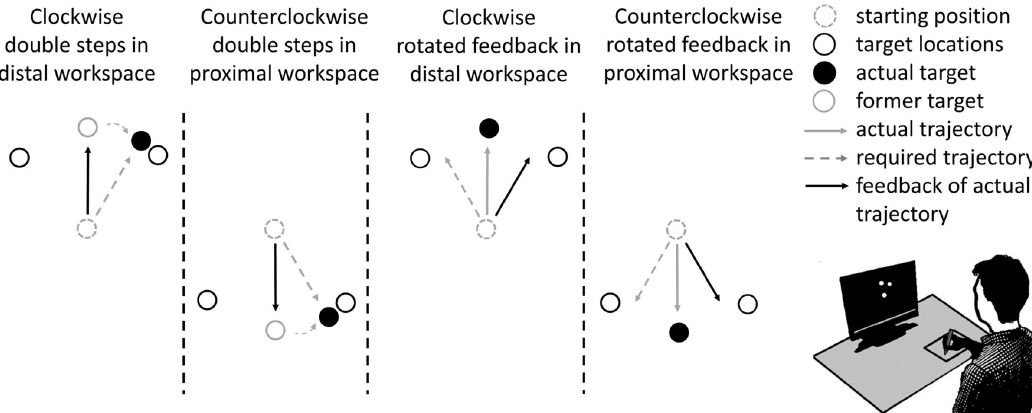
Fig 1. Adaptation tasks. Each participant adapted in the distal and the proximal workspace to double steps as well as to rotated feedback. Double steps represent target displacements at movement onset–here illustrated by a change from a former to the actual target. Clockwise double steps (here shown for the distal workspace) and counterclockwise feedback rotations (here shown for the proximal workspace) require clockwise movement trajectory modifications to reach the target. Counterclockwise double steps (here shown for the proximal workspace) and clockwise feedback rotations (here shown for the distal workspace) require counterclockwise trajectory